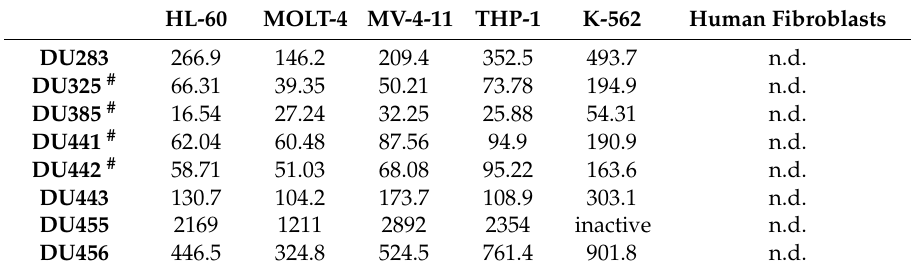
Figure 1. ( A ) General procedure for the preparation of imidazo[1,2- b ]pyrazoles via Groebke-Blackburn-Bienaymé three components reaction (GBB-3CR). ( B ) Structures of imidazo[1,2- b ]pyrazole- 7-carboxamides. IC 50 values (nM) of analogs determined by resazurin assay upon treatment by imidazo[1,2- b